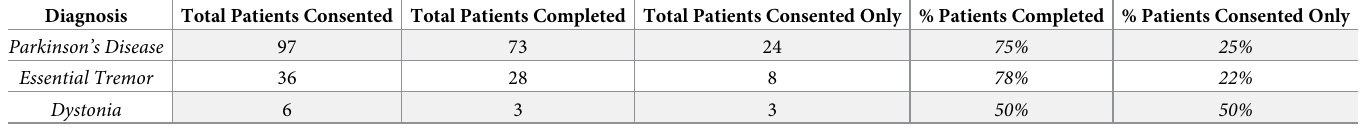
Table 2. Diagnoses of patients consented for DBS research